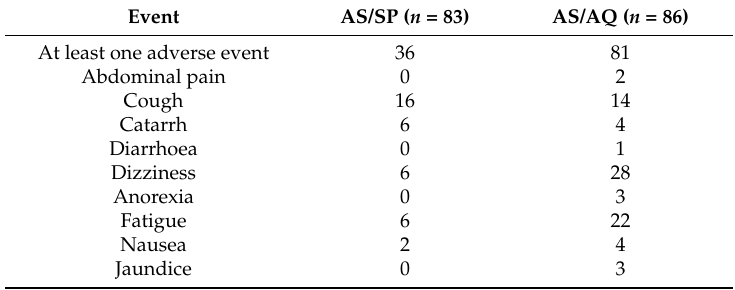
Table 3. Frequency of mild-to-moderate adverse events on days 3–7 (related or not to treatment)